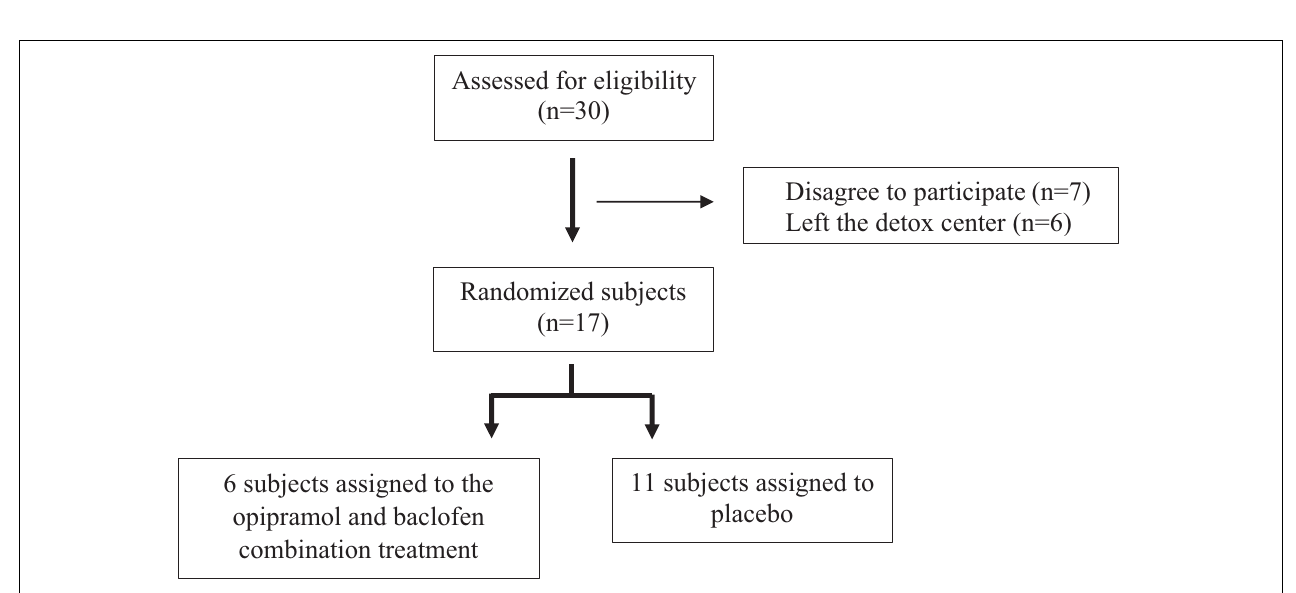
FIGURE 5 | Subject recruitment. Participants were randomly assigned to either the opipramol-baclofen (O/B) combination group or to the placebo group.